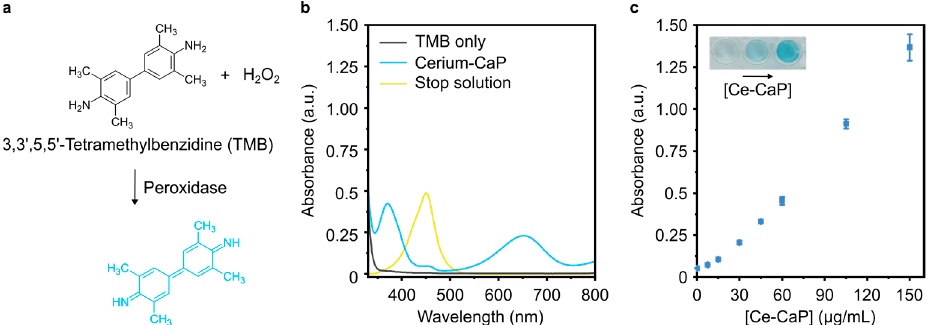
Figure 3. Peroxidase-like activity of Ce-CaP NPs . ( a ) Schematic of the redox reaction between TMB, H2O2, and peroxidase. ( b ) Absorption spectra of samples containing the TMB substrate solution only (grey trace), TMB substrate solution and Ce-CaP NPs at a concentration of 56 μ g/mL (blue trace), or TMB substrate solution, Ce-CaP NPs at a concentration of 56 μ g/mL, and 0.16 M sulfuric acid (stop solution, yellow trace). ( c ) Absorbance of the reaction product measured at 451 nm with varying concentrations of the Ce-CaP NPs. Ce-CaP NPs were added to the TMB substrate solution and the reaction was stopped after 1 min with the addition of a stop solution. Data points are represented as mean ± s.d. (N = 3 independent batches, n = 3 technical replicates). The inset shows the color change due to TMB oxidation with increasing concentration of Ce-CaP NPs.